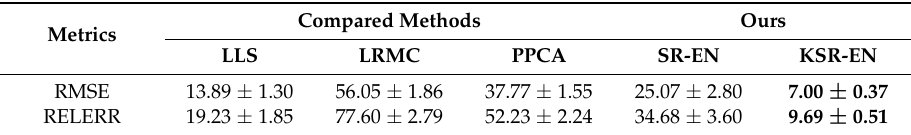
Figure 4. Illustration of coefficient matrix obtained by SR-EN ( left ) and KSR-EN ( right ). Table 1. Imputation error root mean square error (RMSE) and relative error (RELERR) obtained by different approaches. The best results are highlighted in bold.